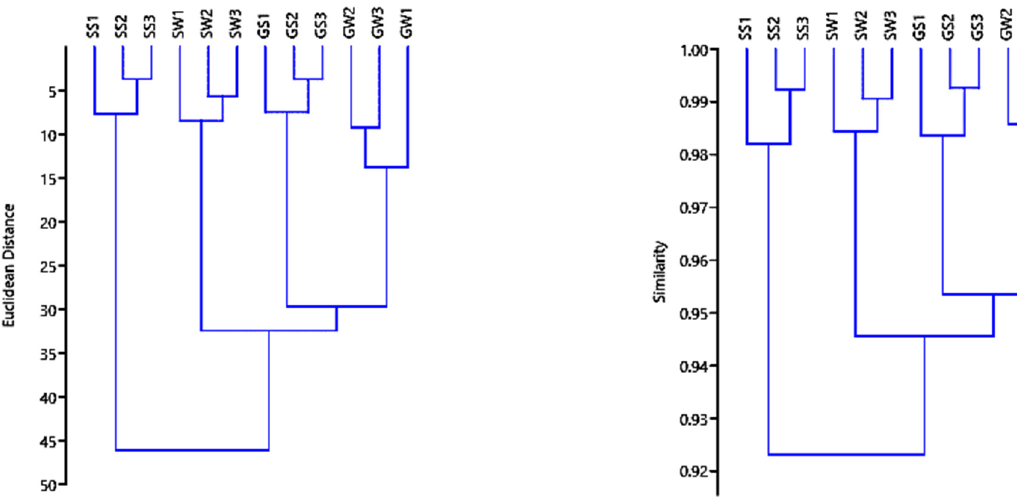
Figure 2. Hierarchical clustering of harvest seasons of Paulownia shan tong using in vitro fermentation kinetic data using sheep or goat ruminal inocula (SS = sheep—spring; SW = sheep—winter; GS = goat—spring; GW = goat—winter).